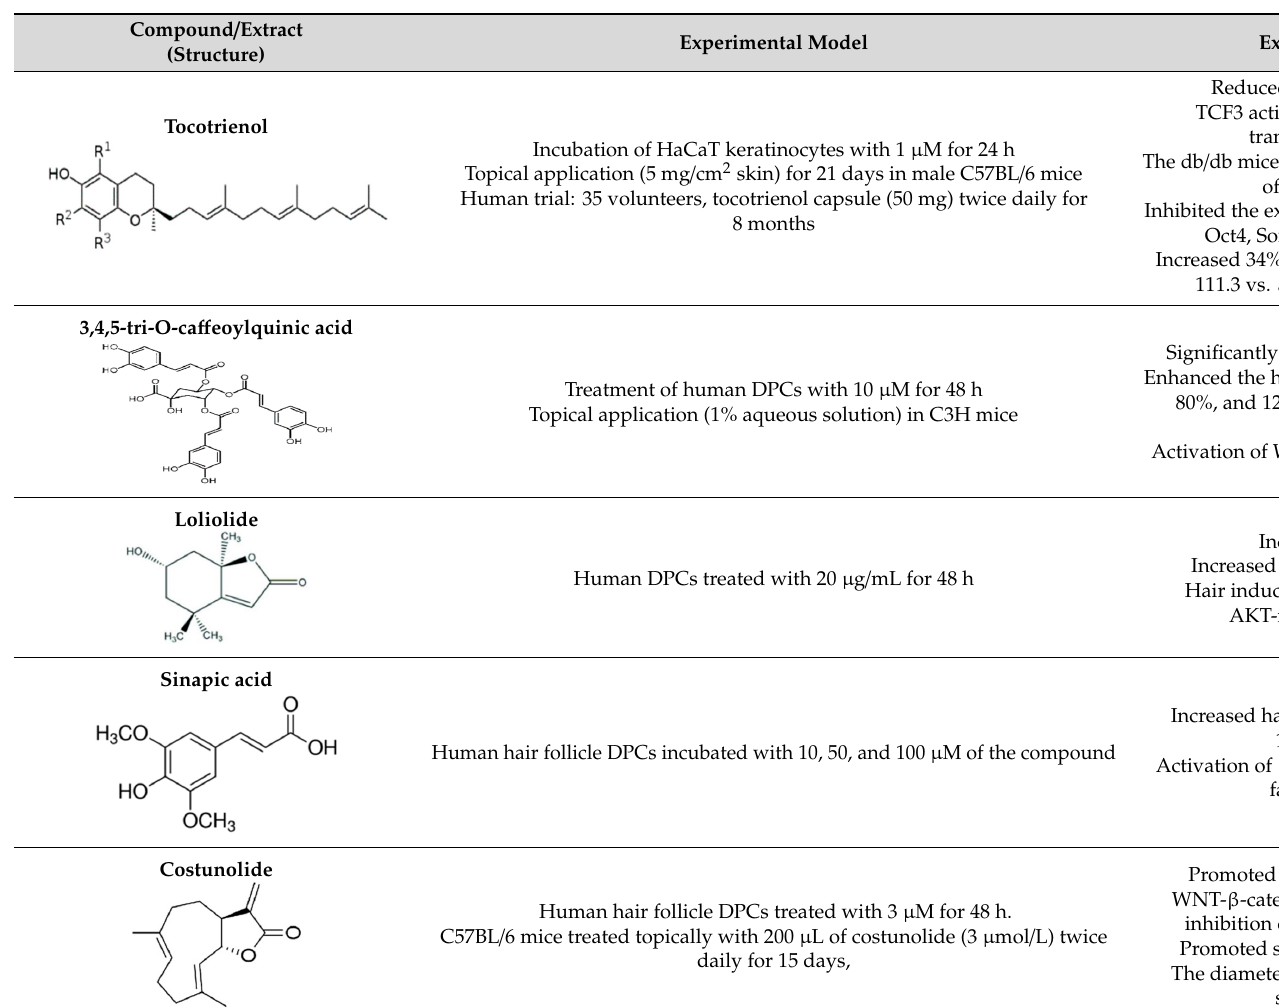
Table 1. Characteristics of natural products acting on the Wnt/b-catenin signaling pathway.